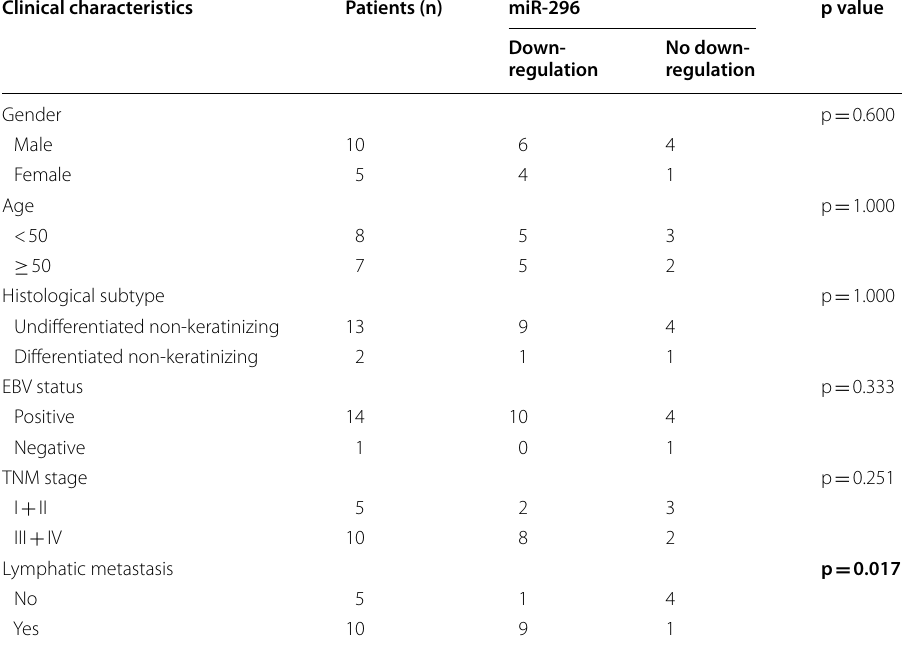
Bold value (p 0.017) indicates statistical differences =